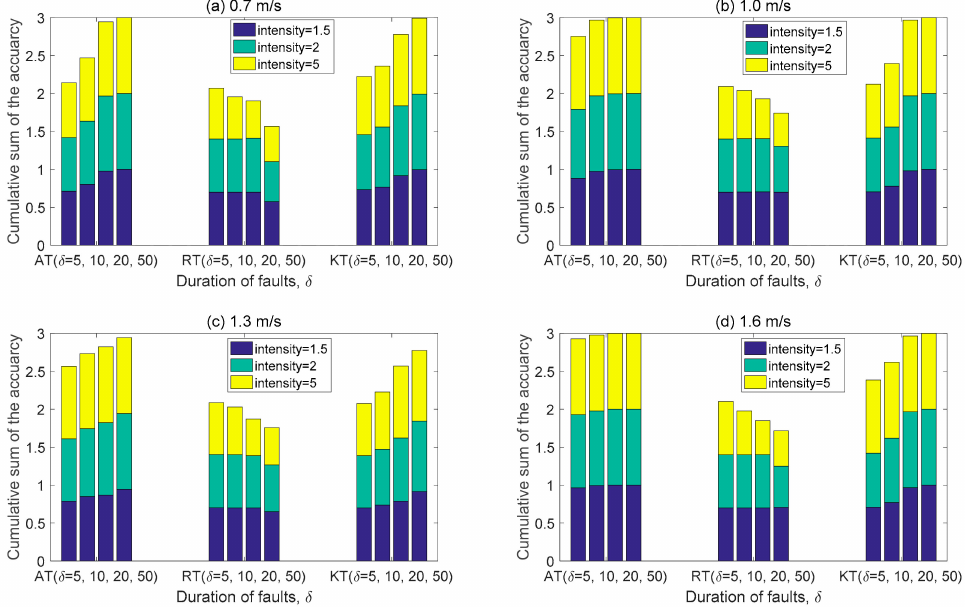
Figure 4. Accuracy according to each intensity as a function of constant fault duration: ( a ) Cumulative sum of the accuracy at 0.7 m/s of Jackal unmanned ground vehicle (UGV); ( b ) Cumulative sum of the accuracy at 1.0 m/s; ( c ) Cumulative sum of the accuracy at 1.3 m/s; ( d ) Cumulative sum of the accuracy at 1.6